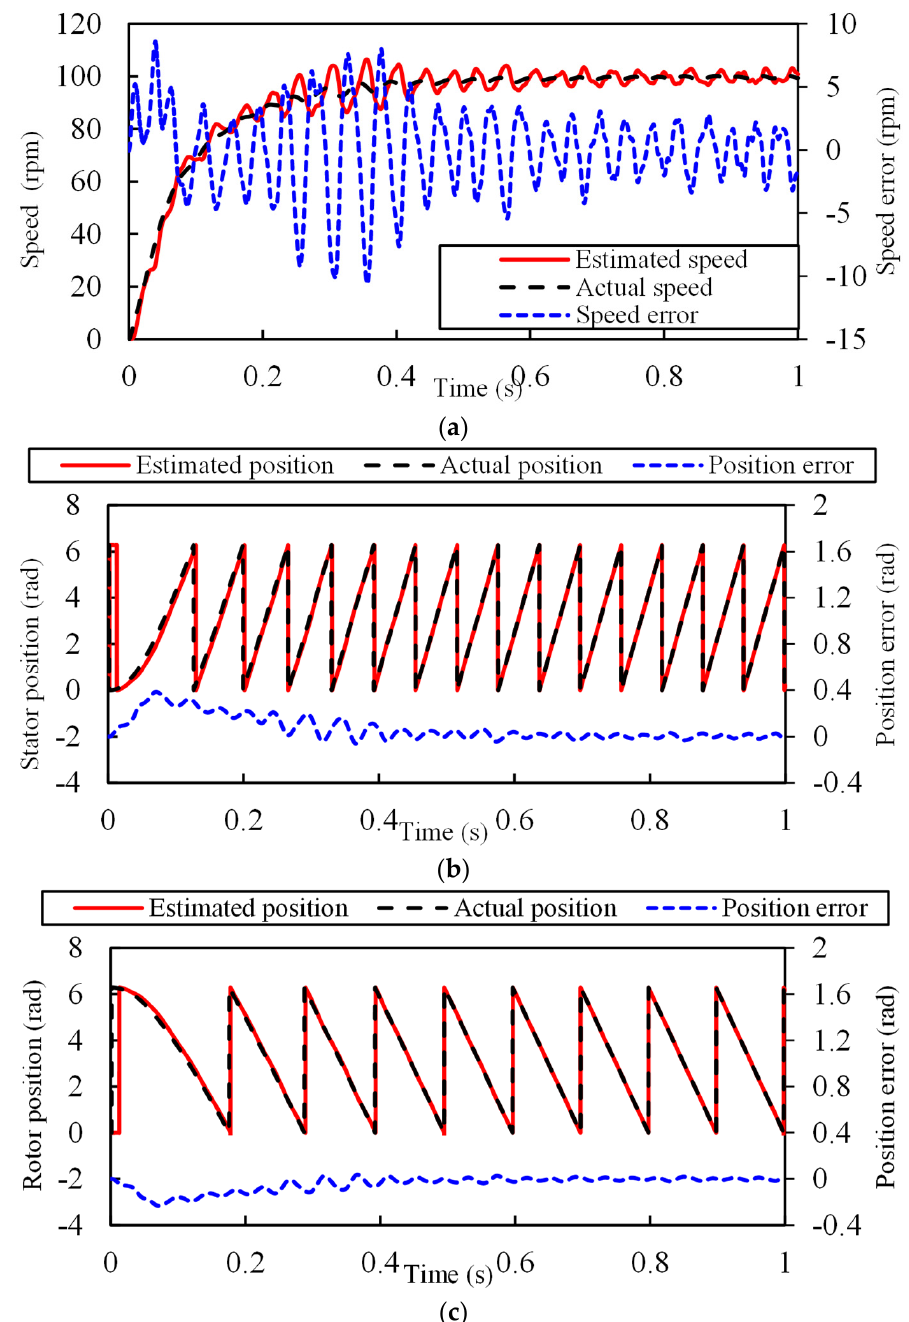
Figure 11. The startup results of estimating from the same side. ( a ) Speed. ( b ) Stator position. ( c ) Rotor position.